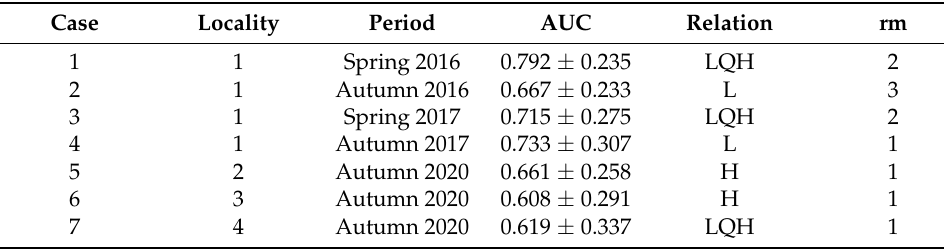
Table 3. Overview of sites, including the setting of binding parameters (L—linear, Q—quadratic, H—threshold) and regularization parameters (rm).